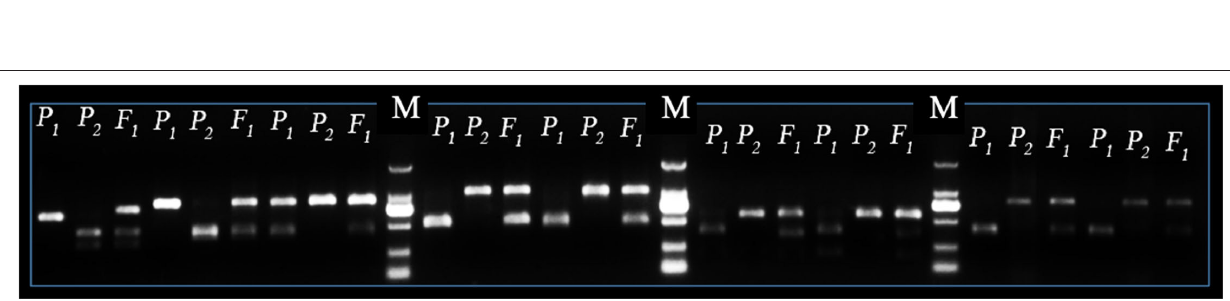
Frontiers in Plant Science |